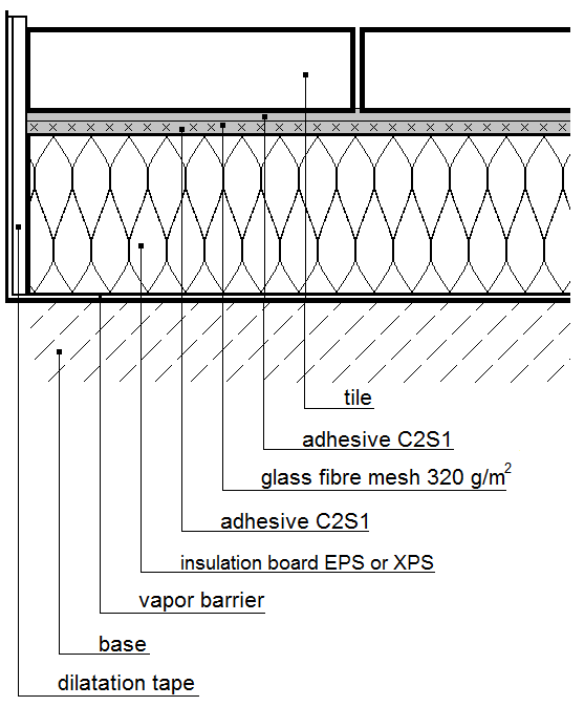
Figure 1: Cross-section of a light floor without screeds with XPS or